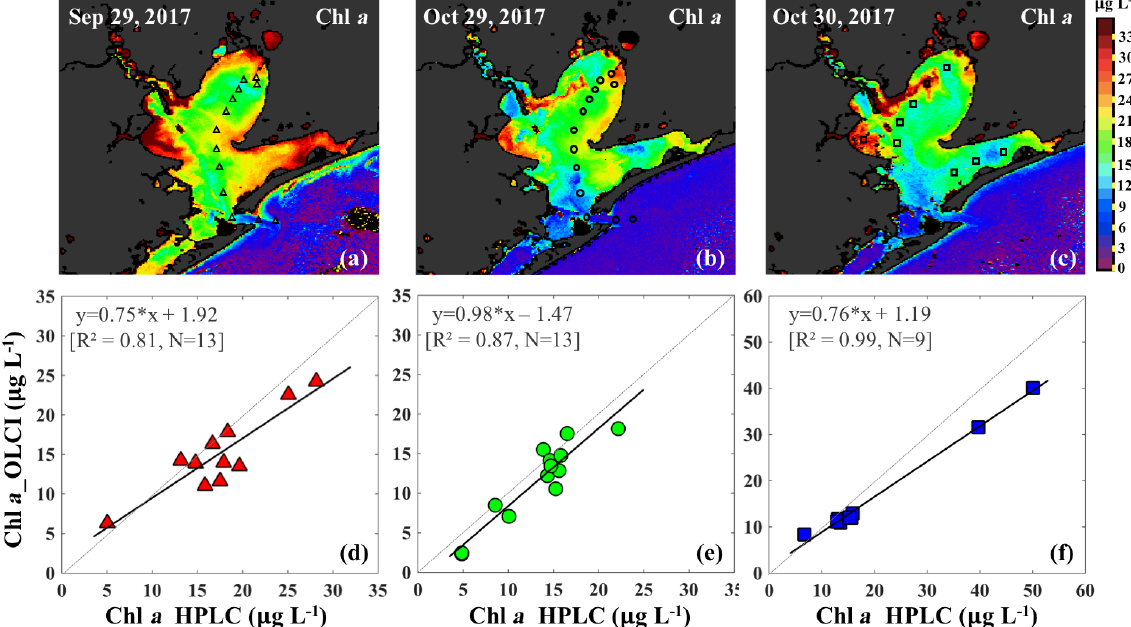
Figure 10. Chl a concentrations generated based on an in situ band ratio ( R rs 673 /R rs 709) algorithm with (a) , (b) and (c) representing Chl a distribution on 29 September, 29 and 30 October 2017, respectively. Panels (d) , (e) and (f) show the validation between HPLC-measured Chl a and OLCI-derived Chl a on 29 September, 29 and 30 October 2017,